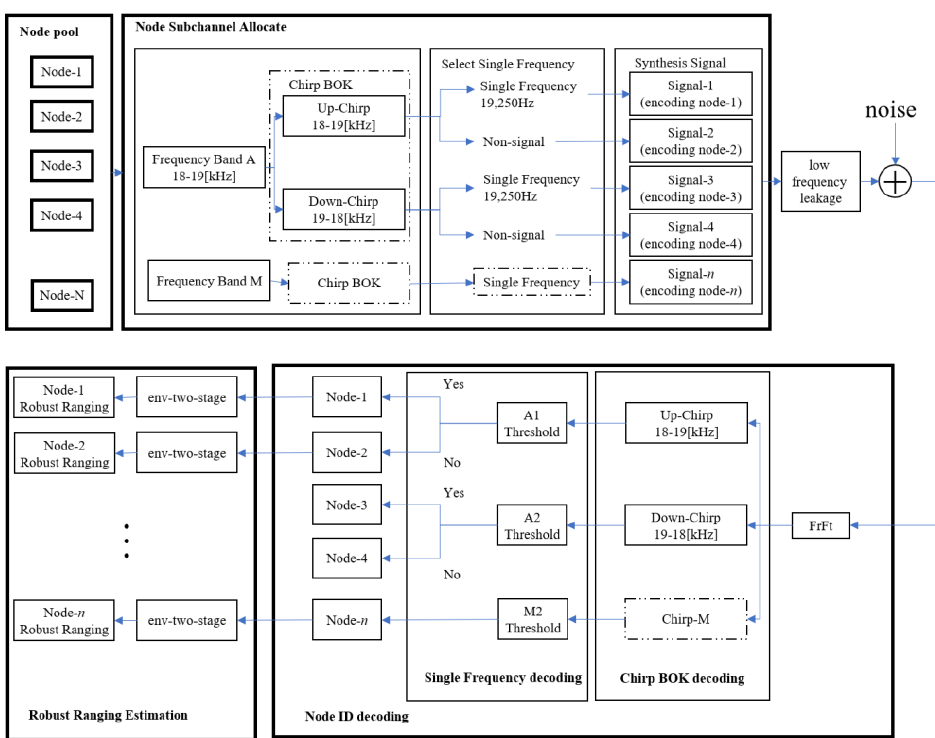
Figure 18. Communication system principle framework.